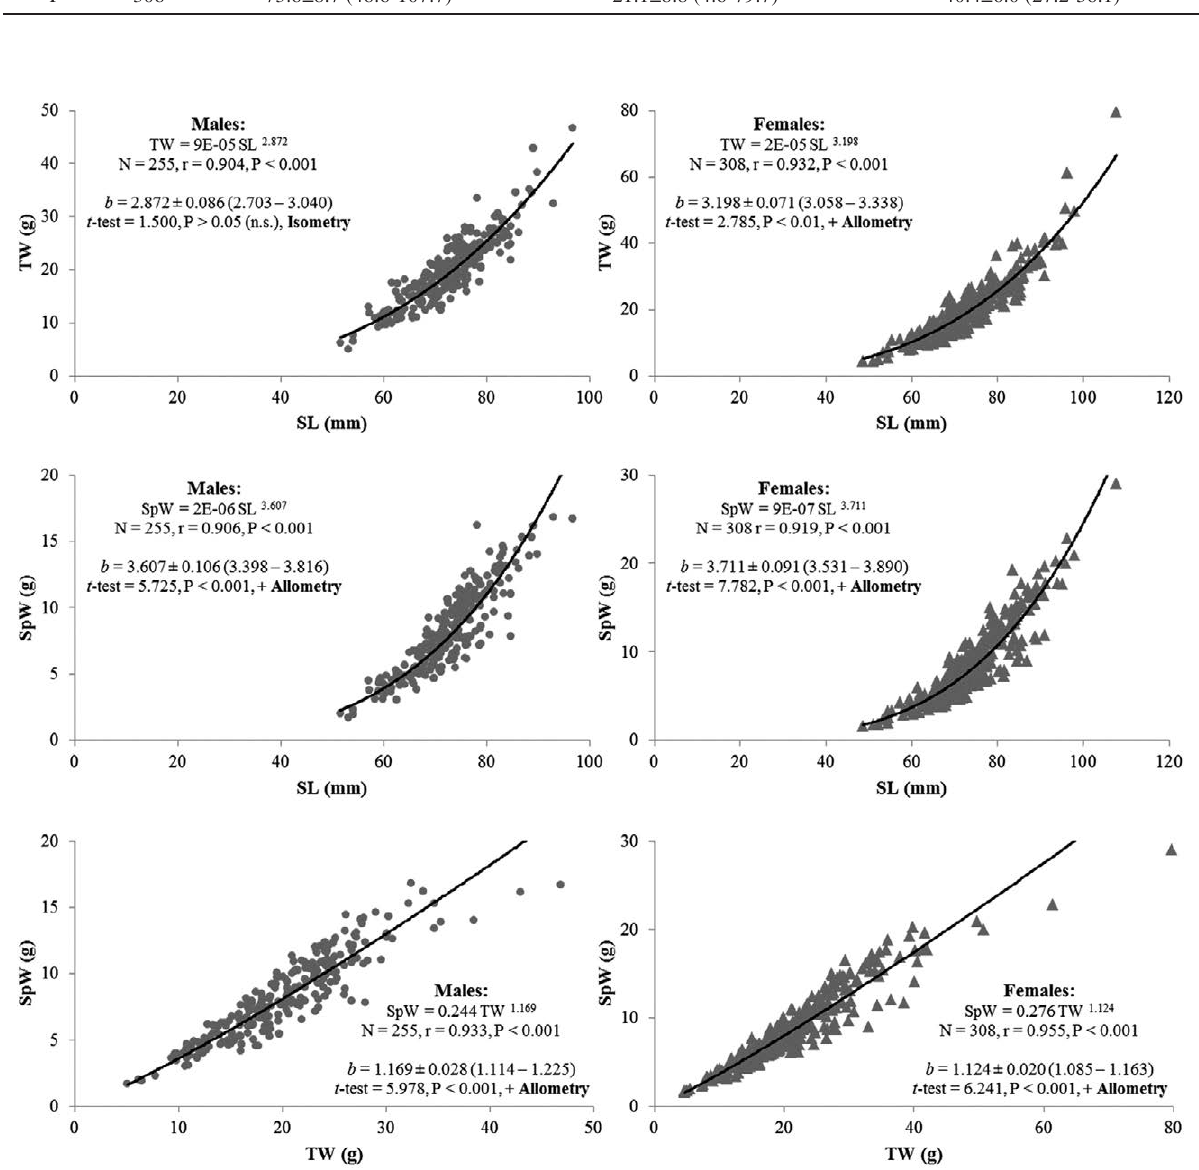
Fig. 3. – Relationships established between shell length (SL), total weight (TW) and soft parts weight (SpW) of Bolinus brandaris 56.1%. There were no statistically significant differ- ences (H=0.667, p>0.05) in the average MY obtained from males (40.7±6.2%; range=25.8-55.3%) and from females (40.4±6.0%; range=27.2-56.1%) (Table 1). The relationships established between specimen SL, TW and SpW in males and females of B. brandaris are presented in Figure 3. In both sexes, all relation- ships were highly significant (p<0.001) and invariably displayed high correlation coefficients (r=0.904 to 0.955), slightly higher in females (r=0.919 to 0.955) than in males (r=0.904 to 0.933) (Fig. 3). Overall, these